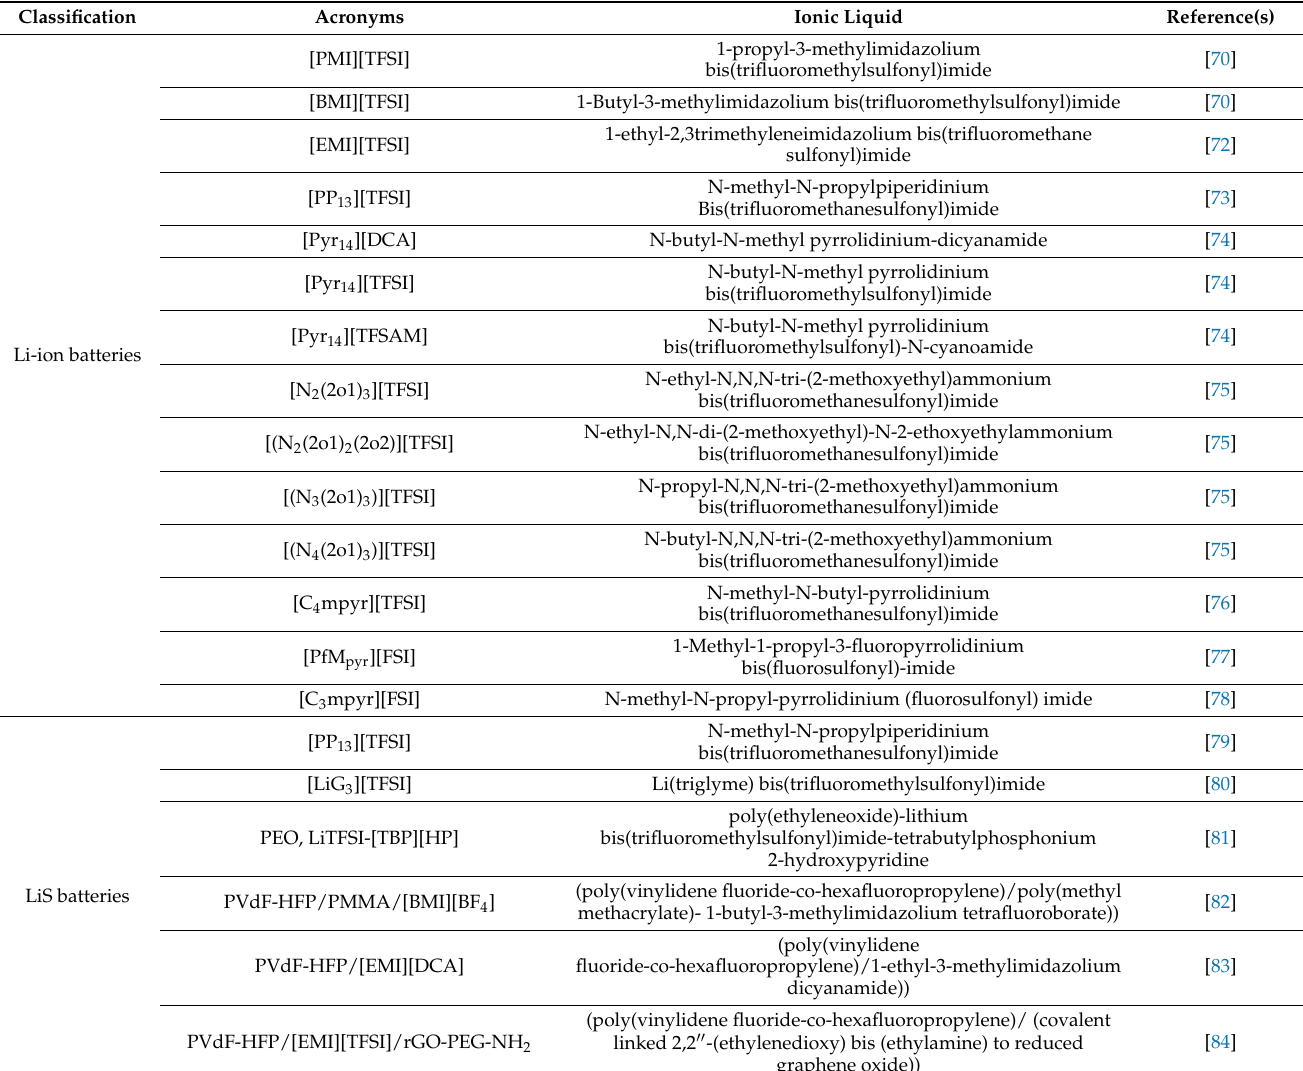
Table 1. The lists of the representative ILs applied in LIBs and SCs as electrolytes.